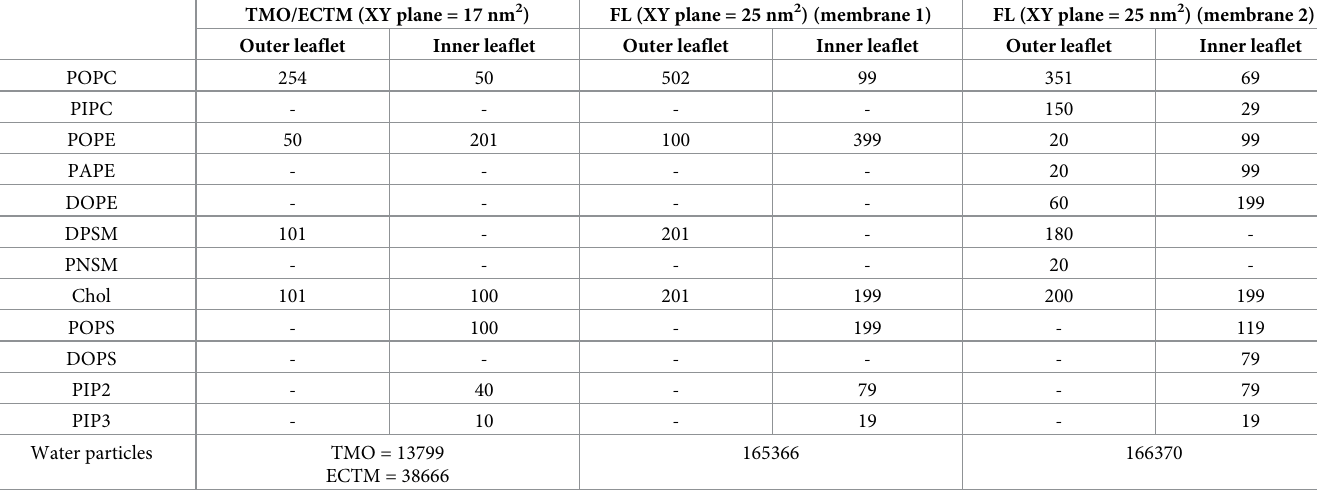
Table 3. Number of lipids in each leaflet of the membranes and the number of CG water particles used in each simulation in this